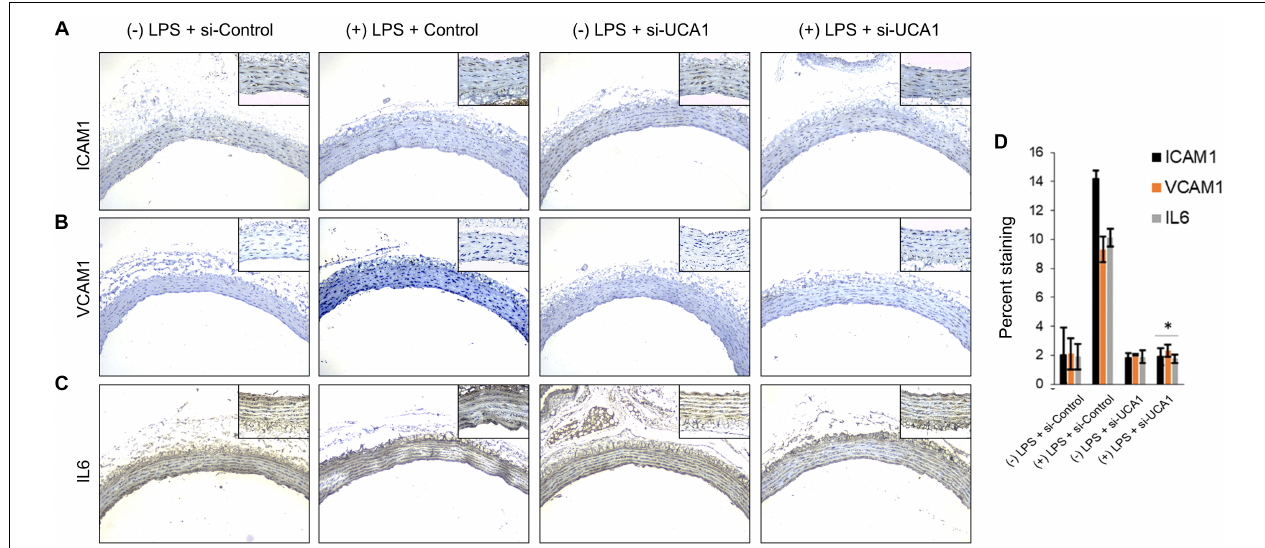
FIGURE 5 | Downregulation of UCA1 using siRNA inhibits sepsis associated induction of ICAM1, VCAM1, and IL6 in vivo . The aorta was isolated and the expression levels of ICAM1, VCAM1, and IL-6 were detected by immunohistochemical staining with IHC. Shown are representative images obtained at 100 × magnification (inset 400 × magnification) of aortic tissue in indicated experimental groups stained with antibody against (A) ICAM1, (B) VCAM1, and IL6 (C) . (D) Quantification of images obtained from 6 animals of each experimental group. ∗ P < 0.05, compared to corresponding specimen in +LPS + siRNA-scramble control group.